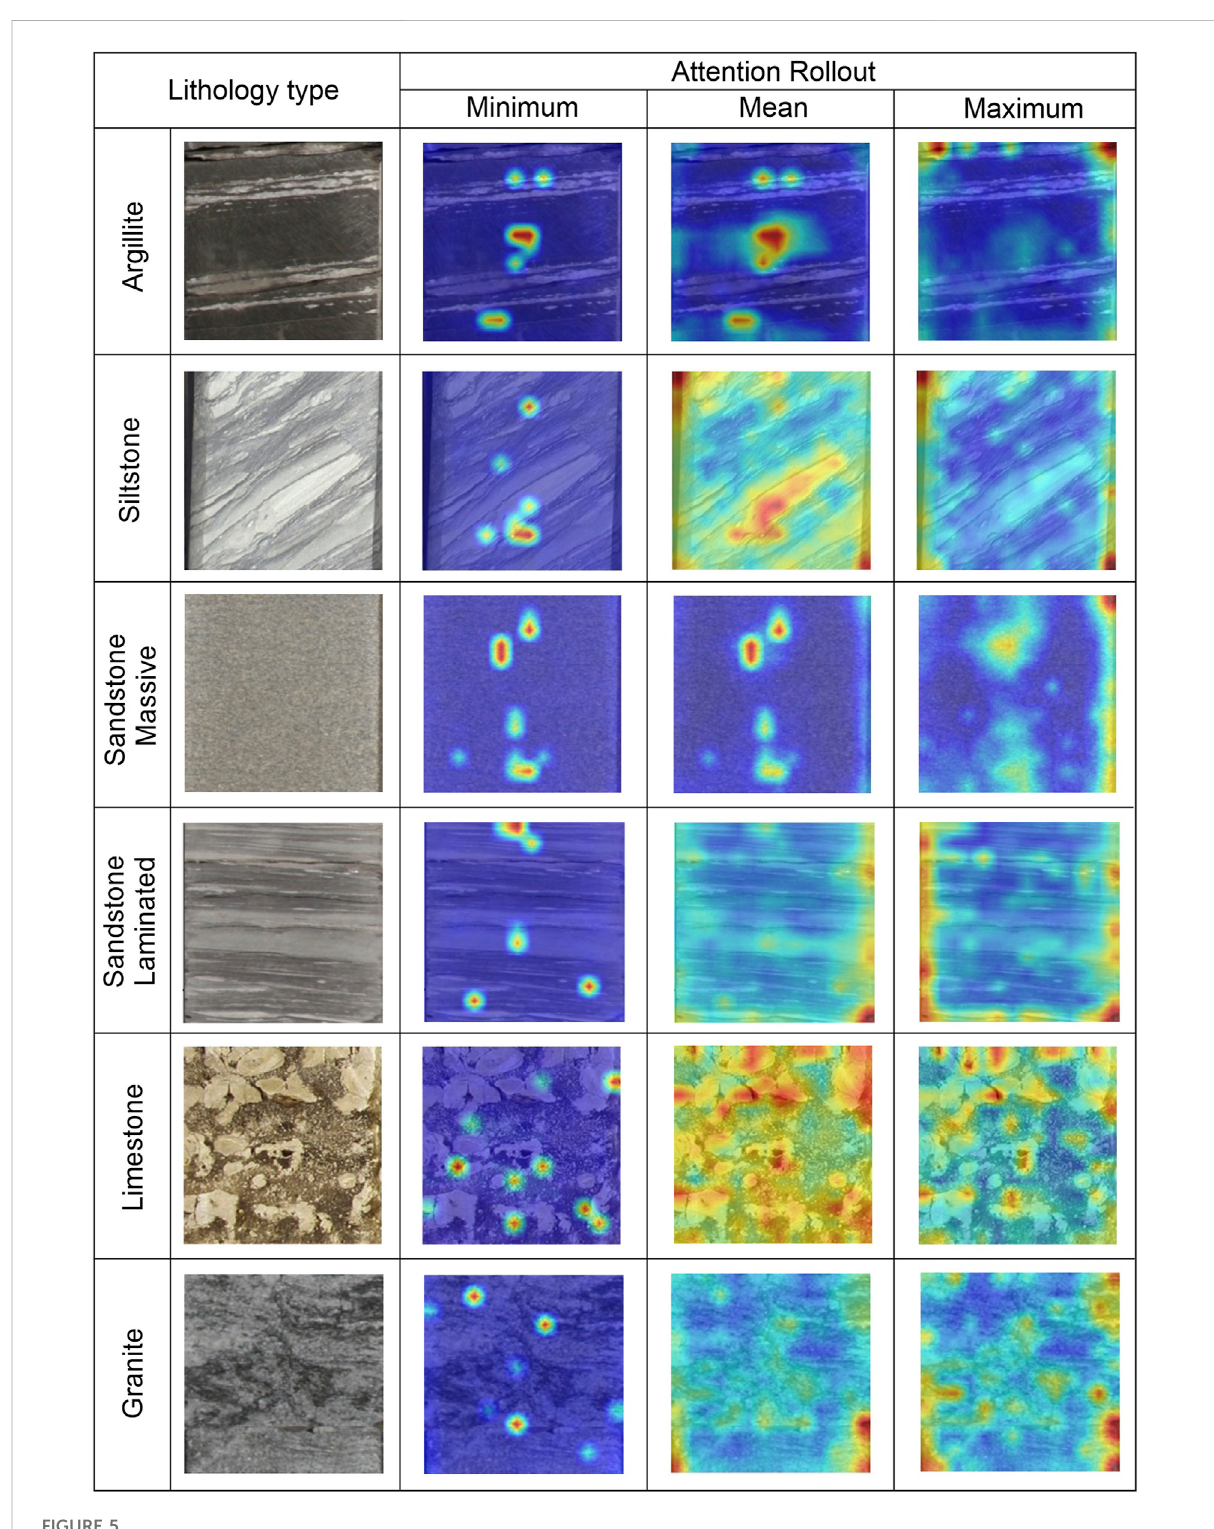
FIGURE 5 Visualizations of learned features within the transformer layers using attention rollout in different rock